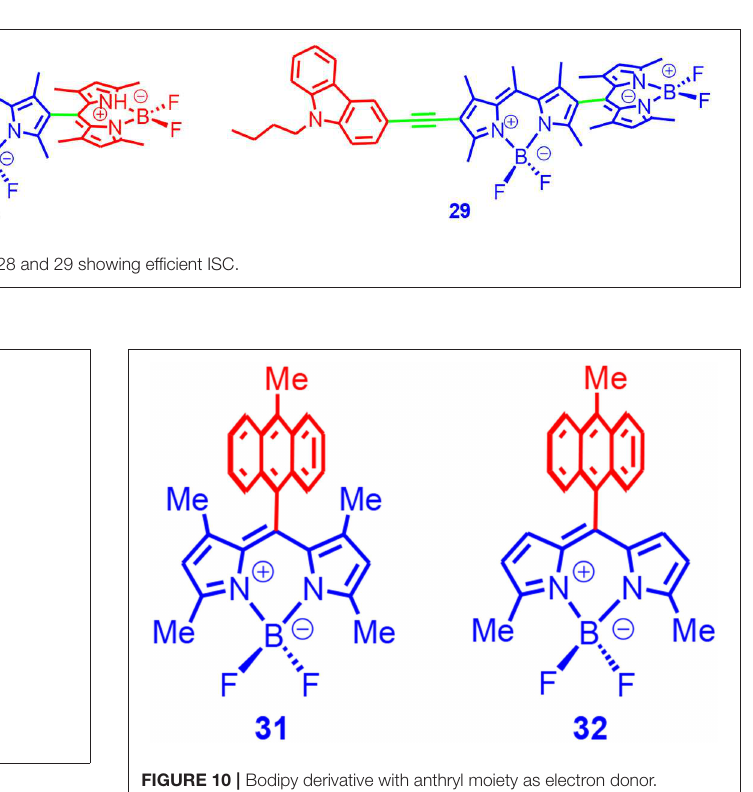
FIGURE 10 | Bodipy derivative with anthryl moiety as electron